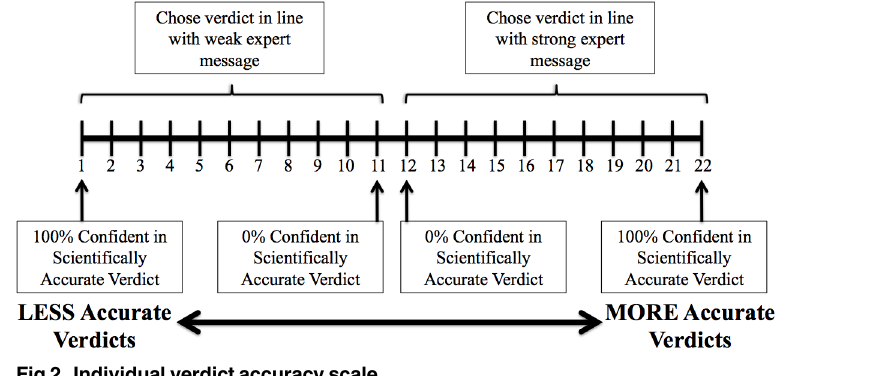
Fig 2. Individual verdict